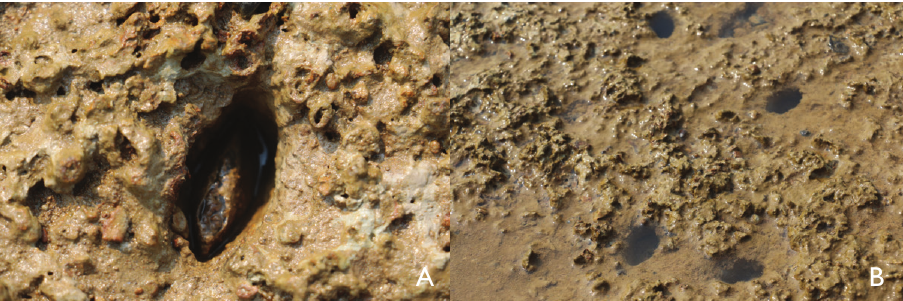
Figure 7. The life style of S. carinata ( A S. carinata used its narrow front end and strong axe to keep dig- ging down to resist erosion from flood waters B S. carinata preferred to inhabit silt or hard